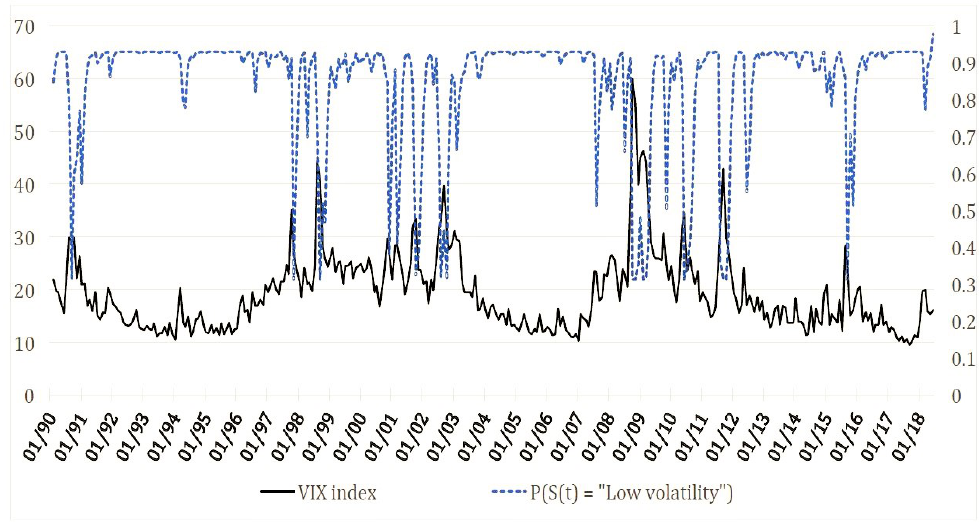
Figure 1. The VIX index and the predicted probabilities from a two-state